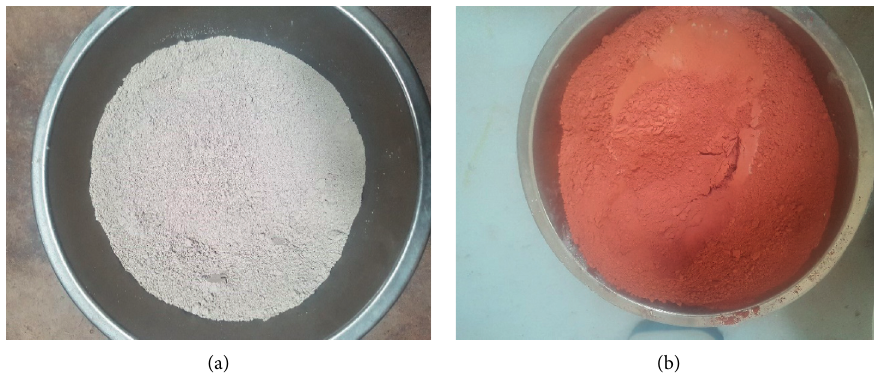
Figure 1: Pumice and scoria powder used in the study.